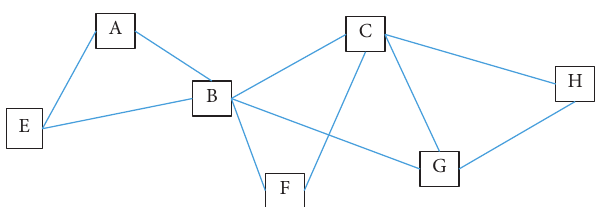
Figure 3: Social network structure